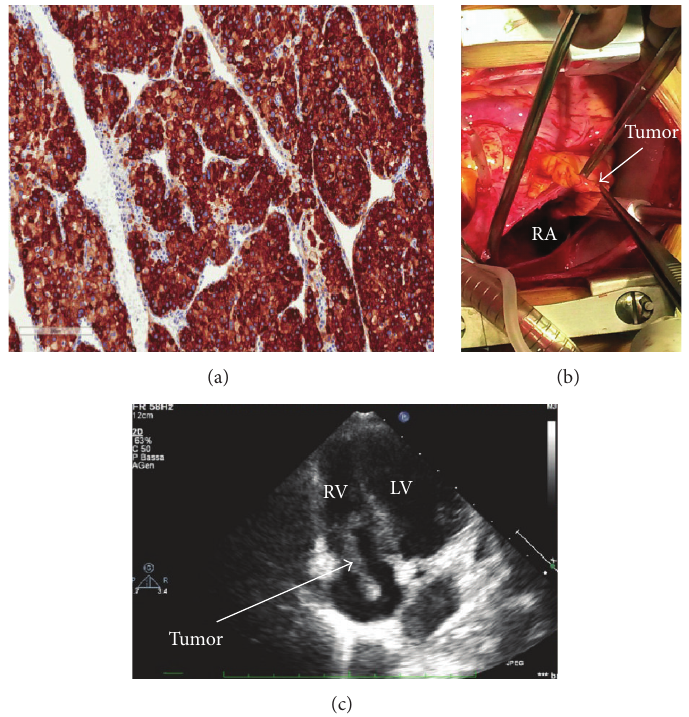
Figure 2: Histopathological examination showing high mitotic activity. Immunoreactivity for the adrenal cortical antigens inhibin (a). Transthoracic echocardiographic (c) findings in the apical four-chamber view showing the serpentine mass extending from the inferior vena cava to the right atrium, through the tricuspid valve to the right ventricle (RV). Intraoperative view (b) showing the tumor after opening of the right atrium